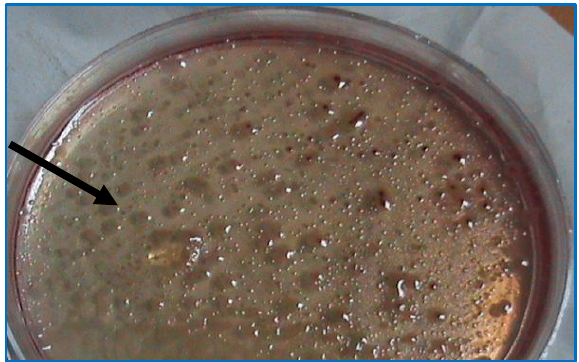
Figure, 1: Sorbitol agar the circular, colorless colonies of E.coli O157:H7.